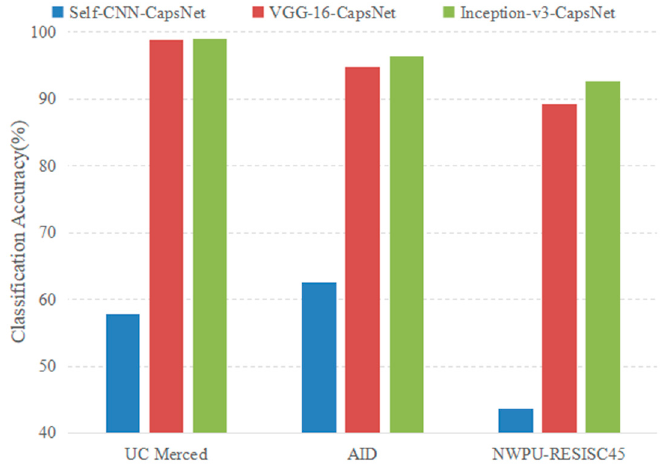
Figure 19. Overall accuracy (%) of the proposed method with neuron and capsule on three datasets. 3.